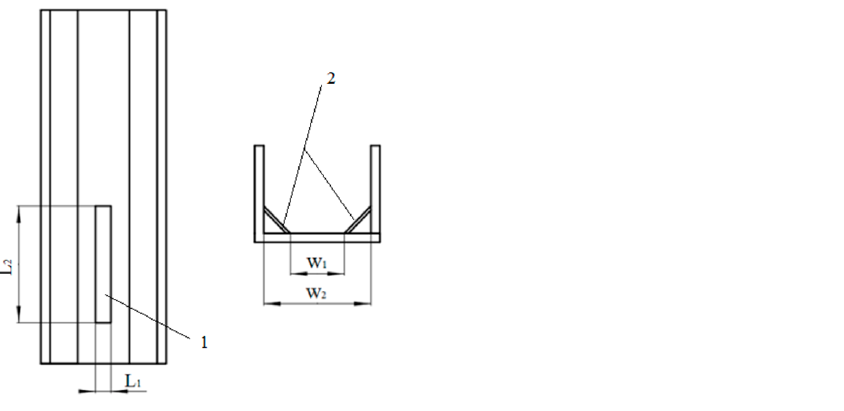
Figure 15. Schematic diagram of the process of the blocks falling into the double-baffle conveyor belt, where 1. through-hole; 2. inclined structures.